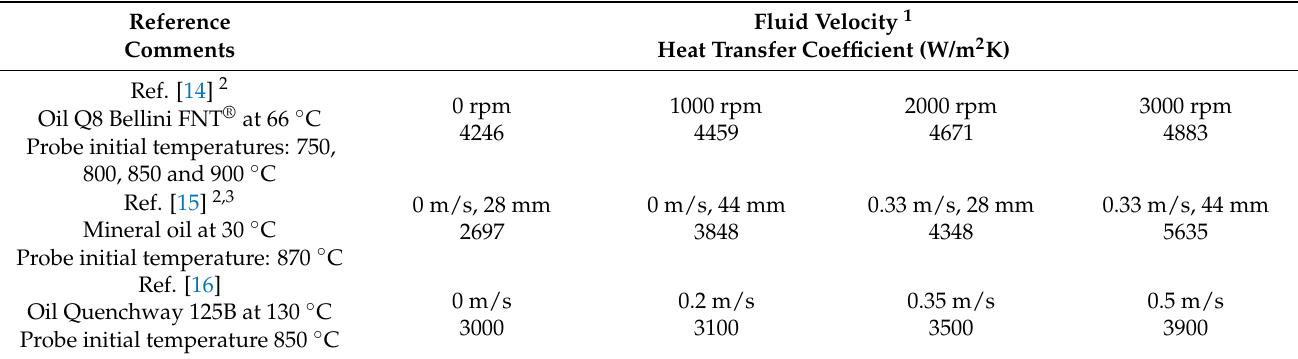
Table 1. Experimentally determined heat transfer coefficients as a function of fluid